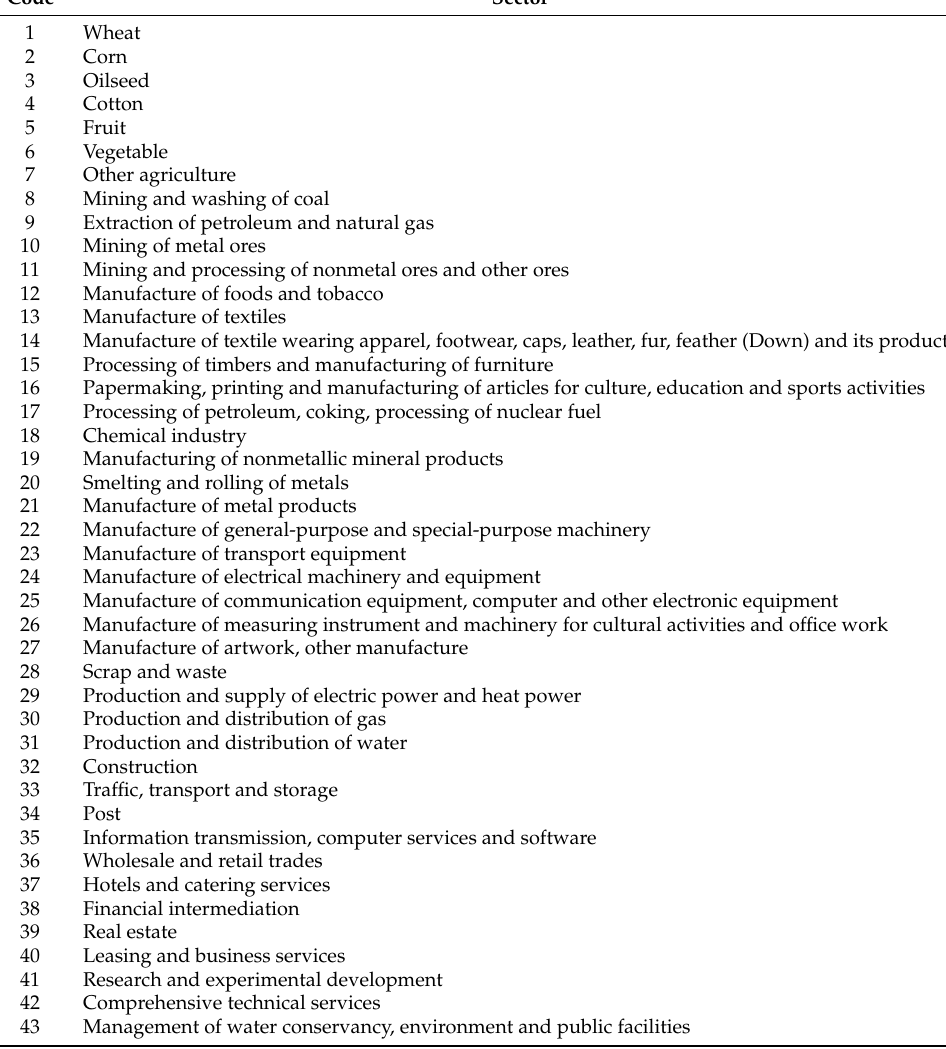
Table A2. The mapping relationship between code and sectors in the CGELUC